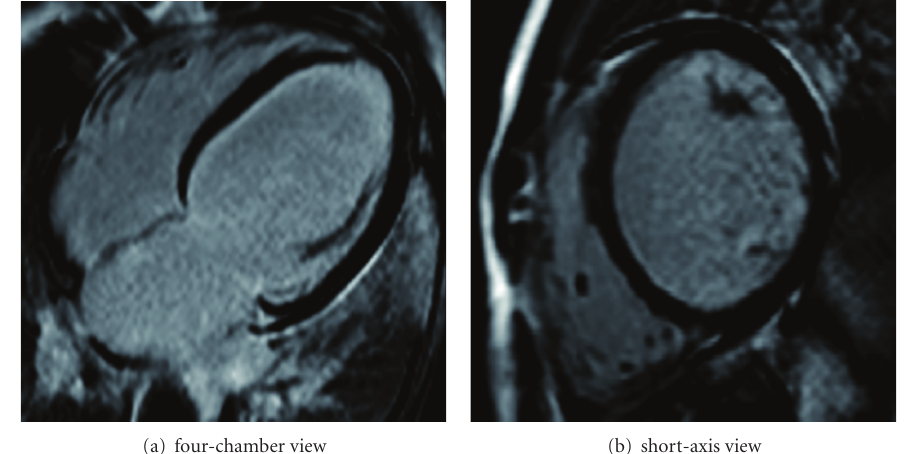
Figure 2: Epicardial late enhancement in the basal inferolateral region in cardiac